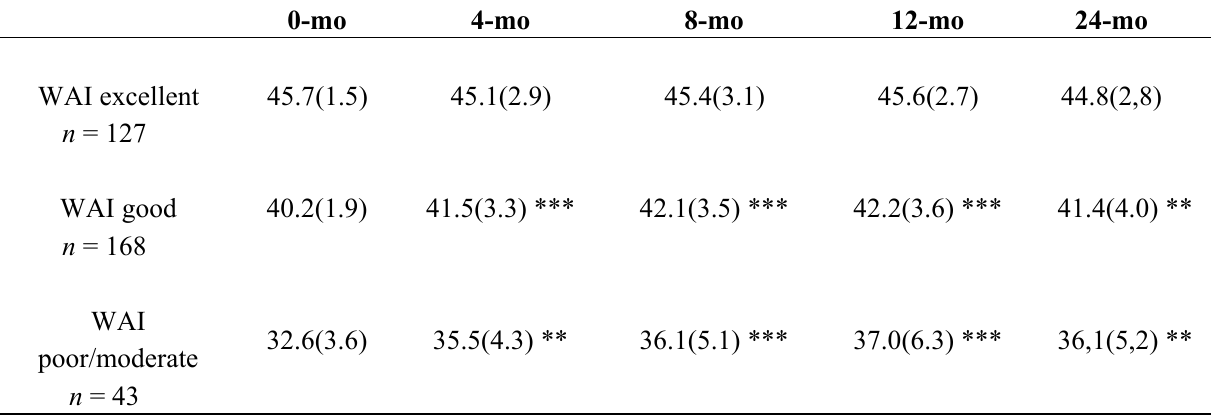
Table 3. Work ability index (WAI) subgroups during intervention (baseline, 4-, 8- and 12-months) and follow-up (24-mo). Mean (SD). The ANCOVA model contains age, sex and BMI as